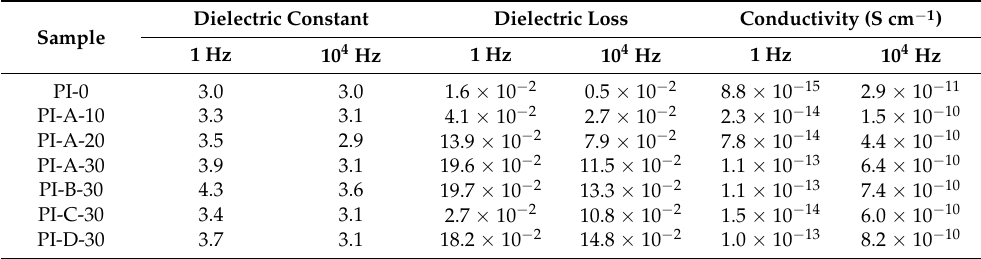
Table 4. Dielectric constant, dielectric loss, and conductivity values, at 25 ◦ C and selected frequencies.